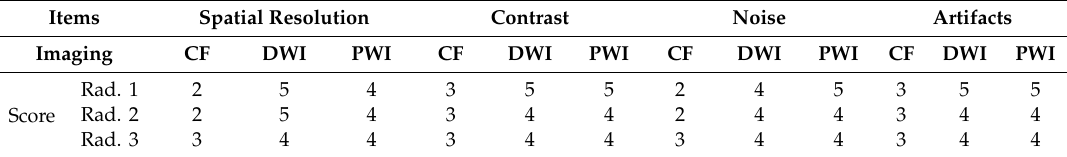
Table 2. Evaluation results of phantom images (Figure 2) reconstructed by CF, DWI, and PWI on the Likert Scale (1–5) from three radiologists (Rad.). DWI and PWI were scored higher than CF in most cases.